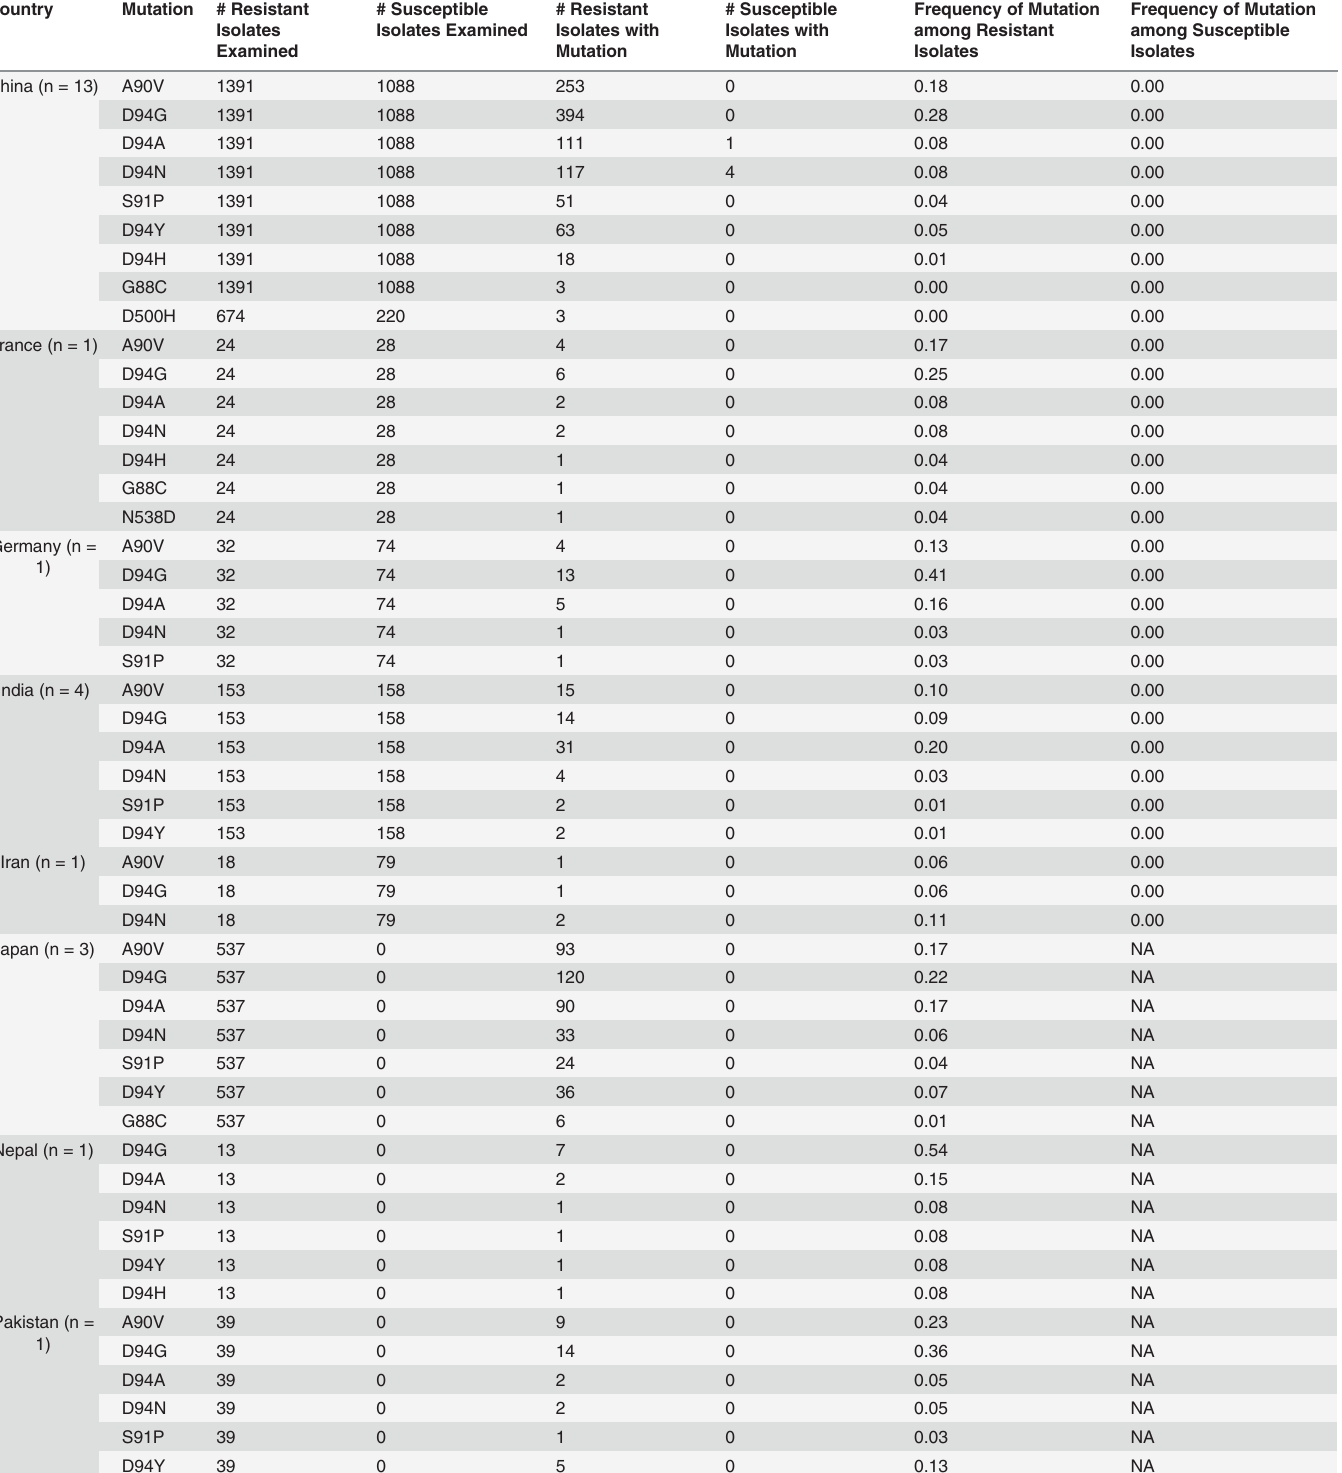
Table 5. Cumulative Frequencies of Selected Mutations within gyrA Gene among Mycobacterium tuberculosis Isolates by Country. Country Mutation # Resistant